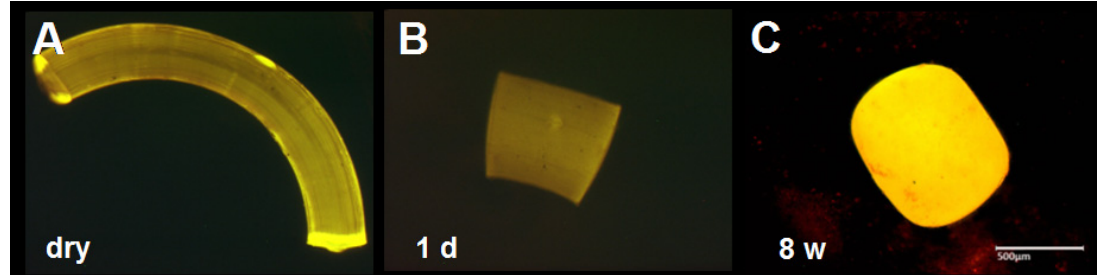
Figure 7. ( A – C ) Morphology of PEA fibrils after incubation in human vitreous humor. As in rabbit vitreous humor, fibrils incubated in human vitreous humor contract, but at eight weeks show less erosion changes. Scale bar, 500 µm. Magnification,